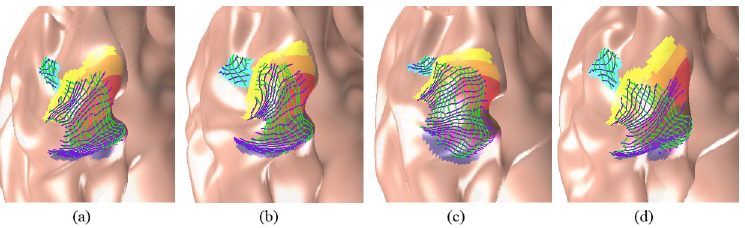
Fig 16. Smoothing extended to the retinotopic map of V3B (the blue color region) of the first four